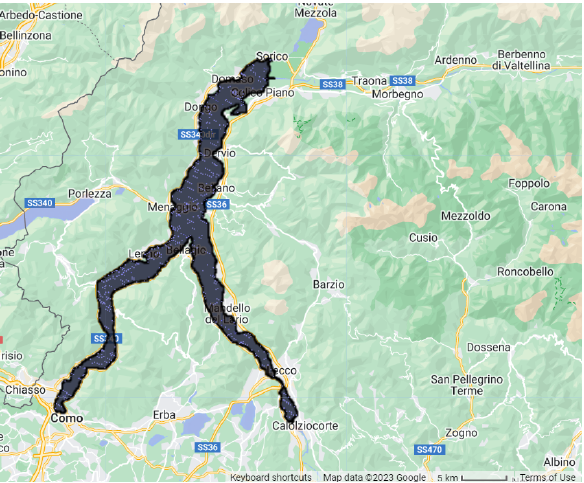
Figure 2. Lake Como extracted boundary from JRC Global Surface Water Mapping Layers and the GEDI footprints within the